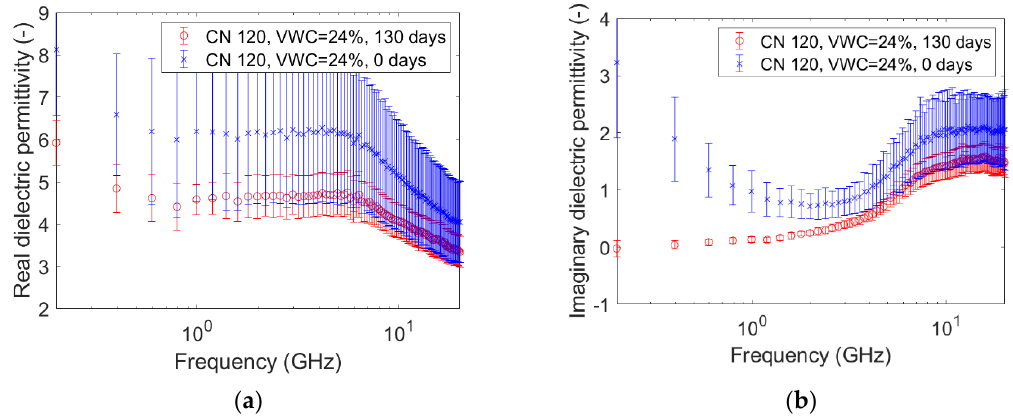
Figure 8. Complex dielectric permittivity before bioremediation and after 130 days: real part ( a ), imaginary part ( b ). Microcosm: C/N = 180. Volumetric water content = 13%.